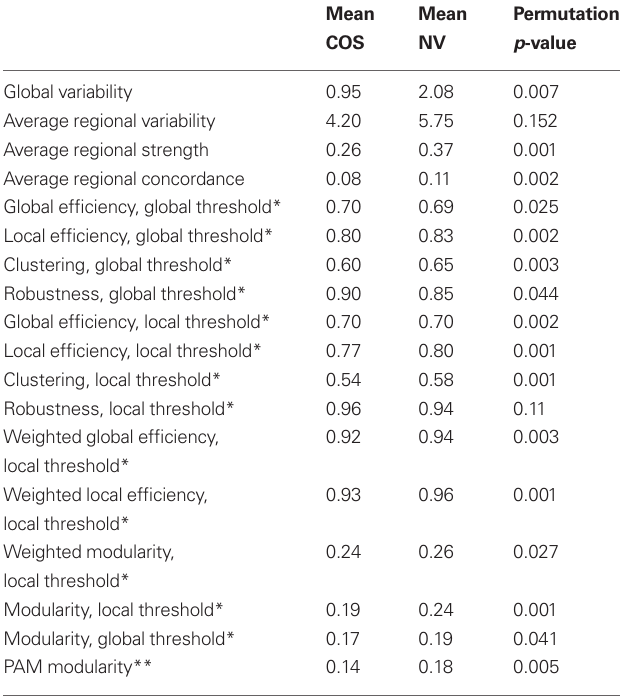
Table 1 | For 18 metrics, the mean value for the childhood-onset schizophrenia (COS) population, the mean value for the controls or “normal volunteers” (NV), and the p -value for a permutation test of the group difference. Tests were based on 2000 permutations.